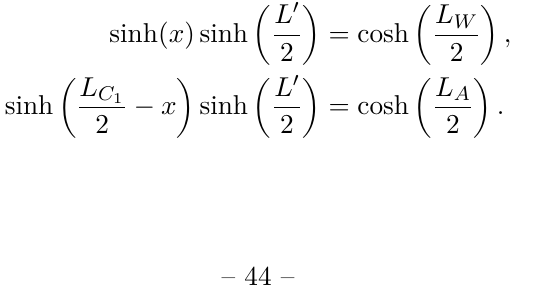
Figure 24 . A pair of pants decomposition of a four-boundary wormhole. The constituent three- boundary wormholes have horizons γ entanglement wedge cross section in our analysis. However, another possible non-trivial entan- glement wedge cross section surface γ 0 exists with an area L 0 that could be lesser in regions of parameter